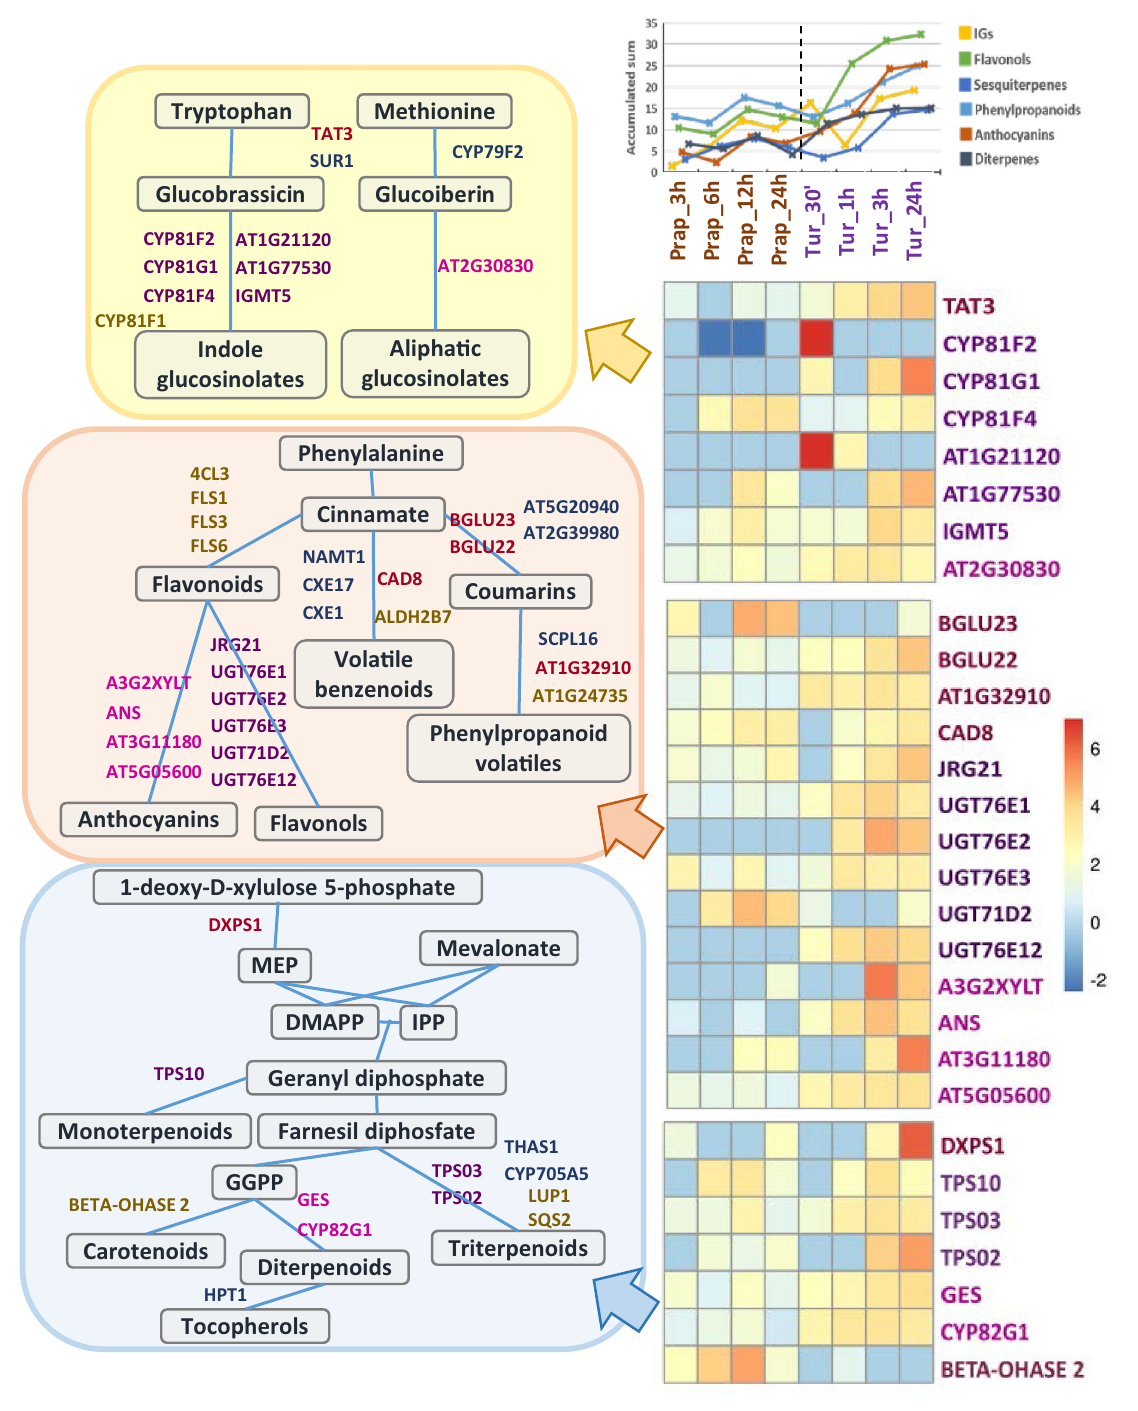
Figure 6. Analysis of secondary metabolic pathways upon T. urticae and P. rapae infestation. The left column shows schematic representations of the pathways leading to the synthesis of main secondary metabolites involved in plant defense. Colour names from pink-based palette identify enzymes involved in different steps or branches of a pathway. Green names correspond to enzymes exclusively up regulated upon T. urticae infestation. The right column englobes a linear graphic showing the accumulated expression of the DEGs involved in the synthesis of the main secondary compounds and heatmaps showing the relative expression in the pathway of every DEG with a fold change higher than four at least in one